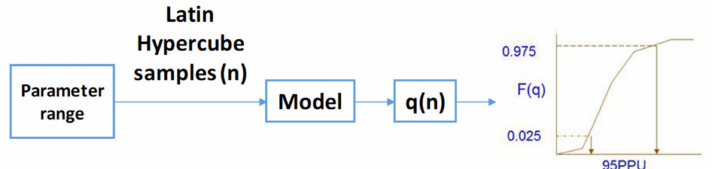
Figure 2. Obtaining the 95% probability distribution (95PPU) using SWAT-CUP to quantify parameter uncertainty